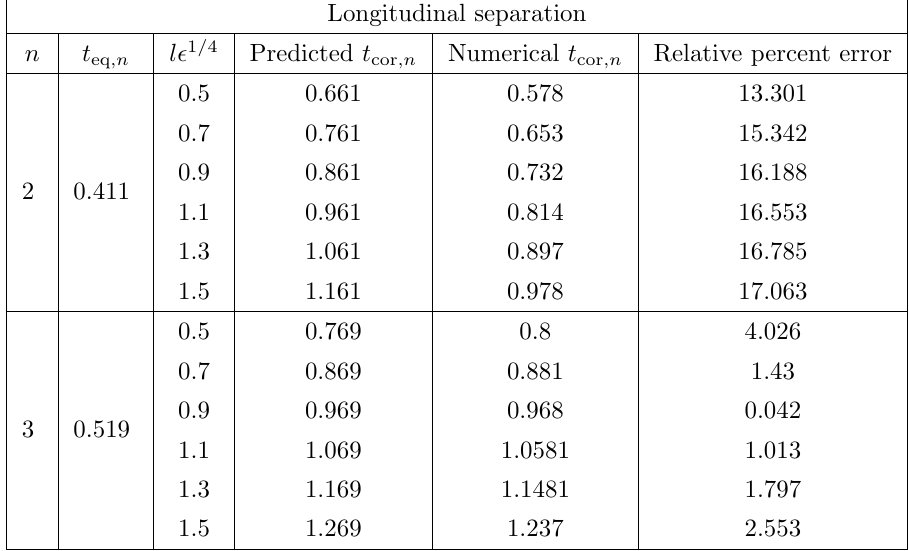
deviation must stem from non-local correlations or rather from the interaction of the two the point ( t = t ; x = 0). This gives a quantitative measure for the non-local eq ; 2